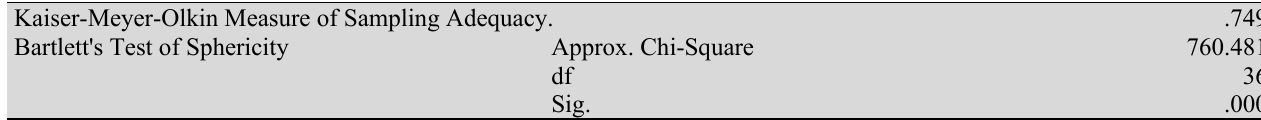
KMO and Bartlett's